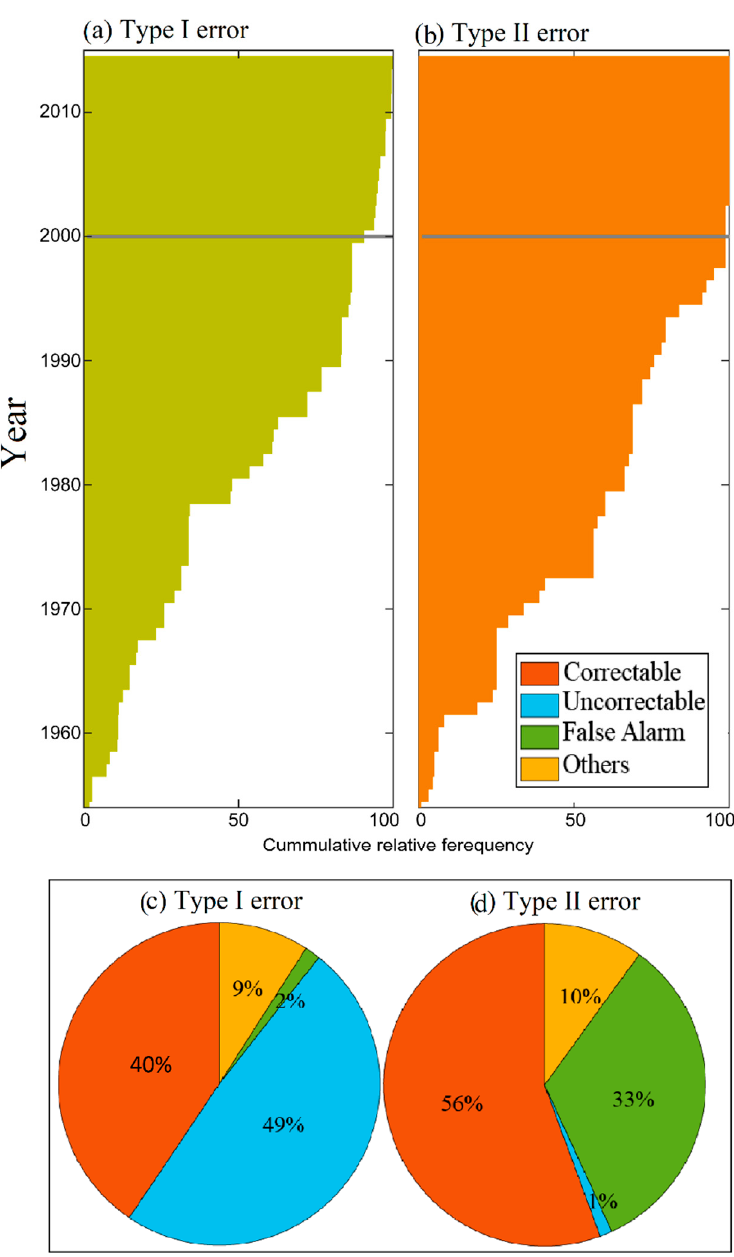
Figure 6. Cumulative relative frequency of days with errors in the rainfall dataset from 1954 to 2014 ( a , b ) and the percentage contribution of each source of error to total error ( c , d ). The horizontal line in a and b indicates the date when the analog system was replaced by the digital system.